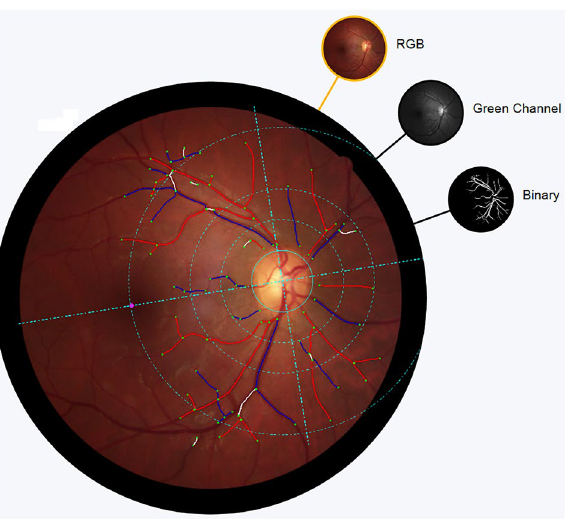
Figure 1. Example of retinal coordinates and zones used by Vampire. The definition of retinal coordinates (x axis through OD and macula centers, origin in the OD center) and circular concentric zones around the OD center, namely, zone A (between 0.5 and 1.0 optic disc diameter (ODD) from OD center), zone B (between 1.0 and 1.5 ODD from OD center) and zone C (between 1.0 and 2.5 ODD from OD